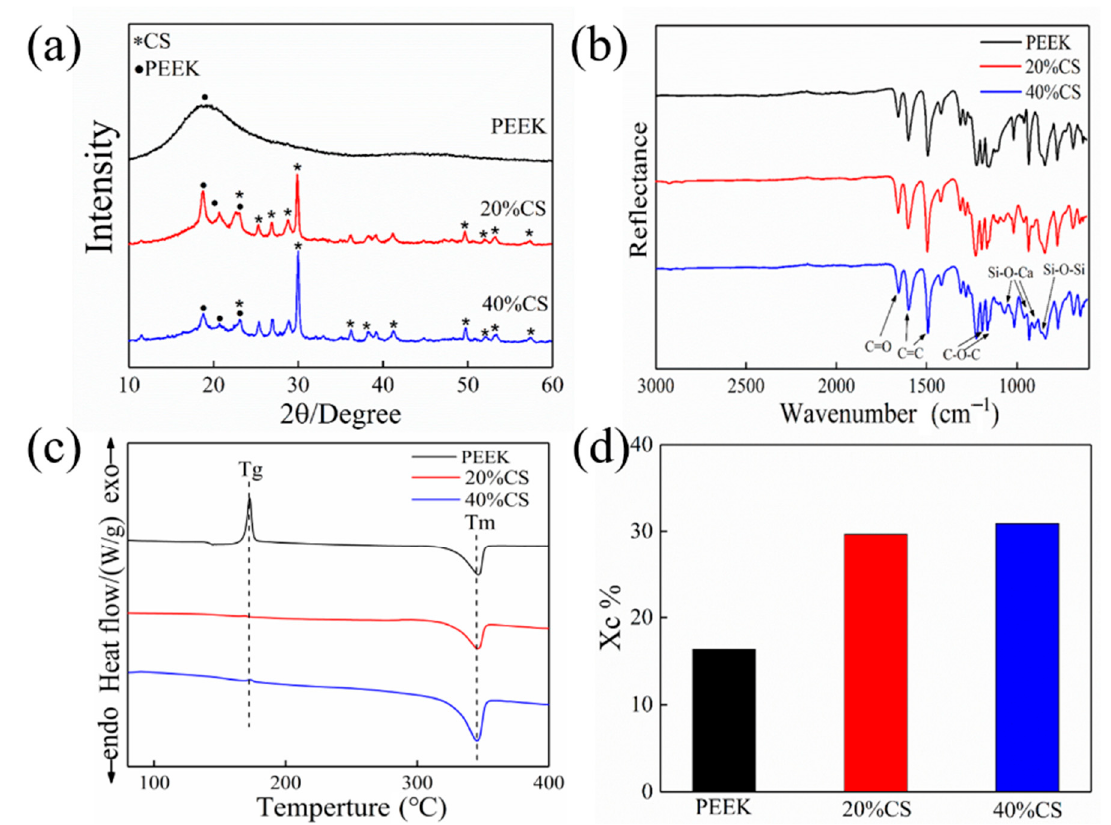
Figure 3. ( a ) XRD patterns, ( b ) FTIR spectra, ( c ) DSC curves, ( d ) crystallinity results of PEEK and PEEK/CS composites.